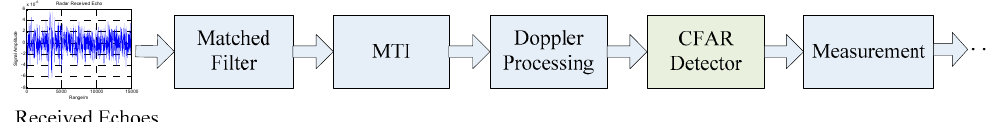
Figure 4. A signal processing diagram of the Pulse Doppler radar.